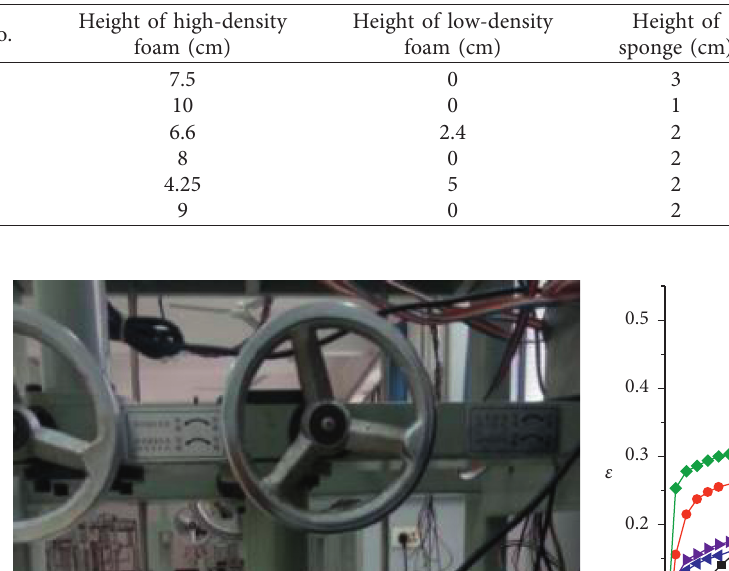
Table 1: Combination design of wood and sponge for different filling ratios.